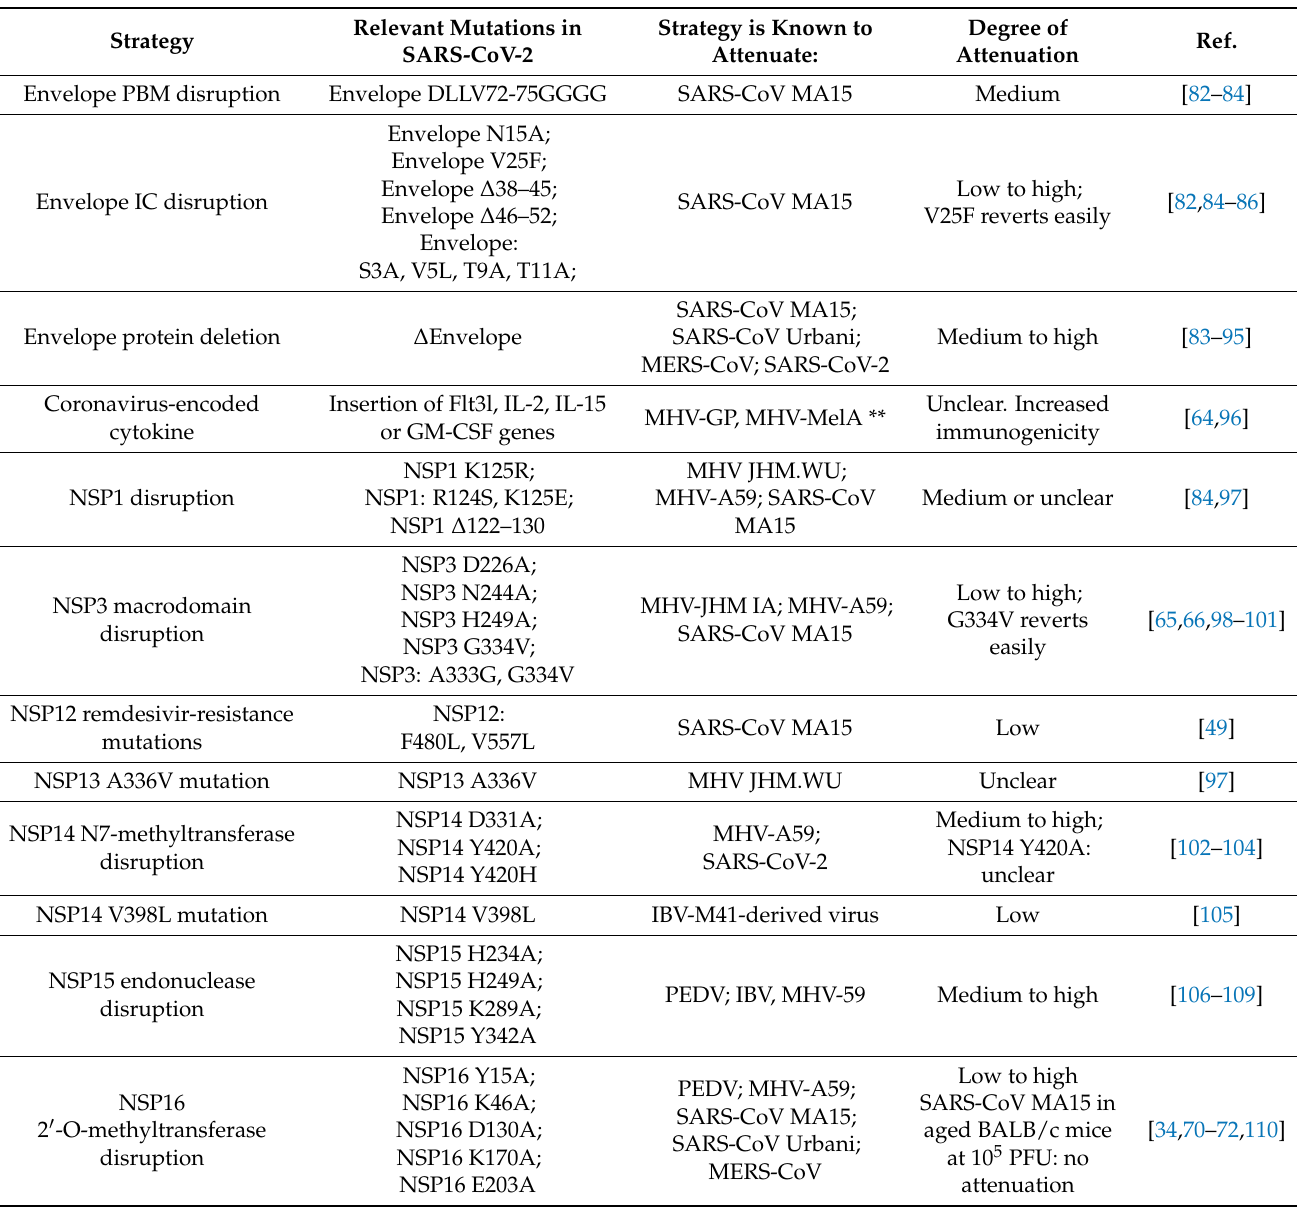
Table 1. A complete list of mutations known to attenuate coronaviruses, which can be applied to